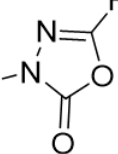
Figure 1. The general structure of the studied compounds.